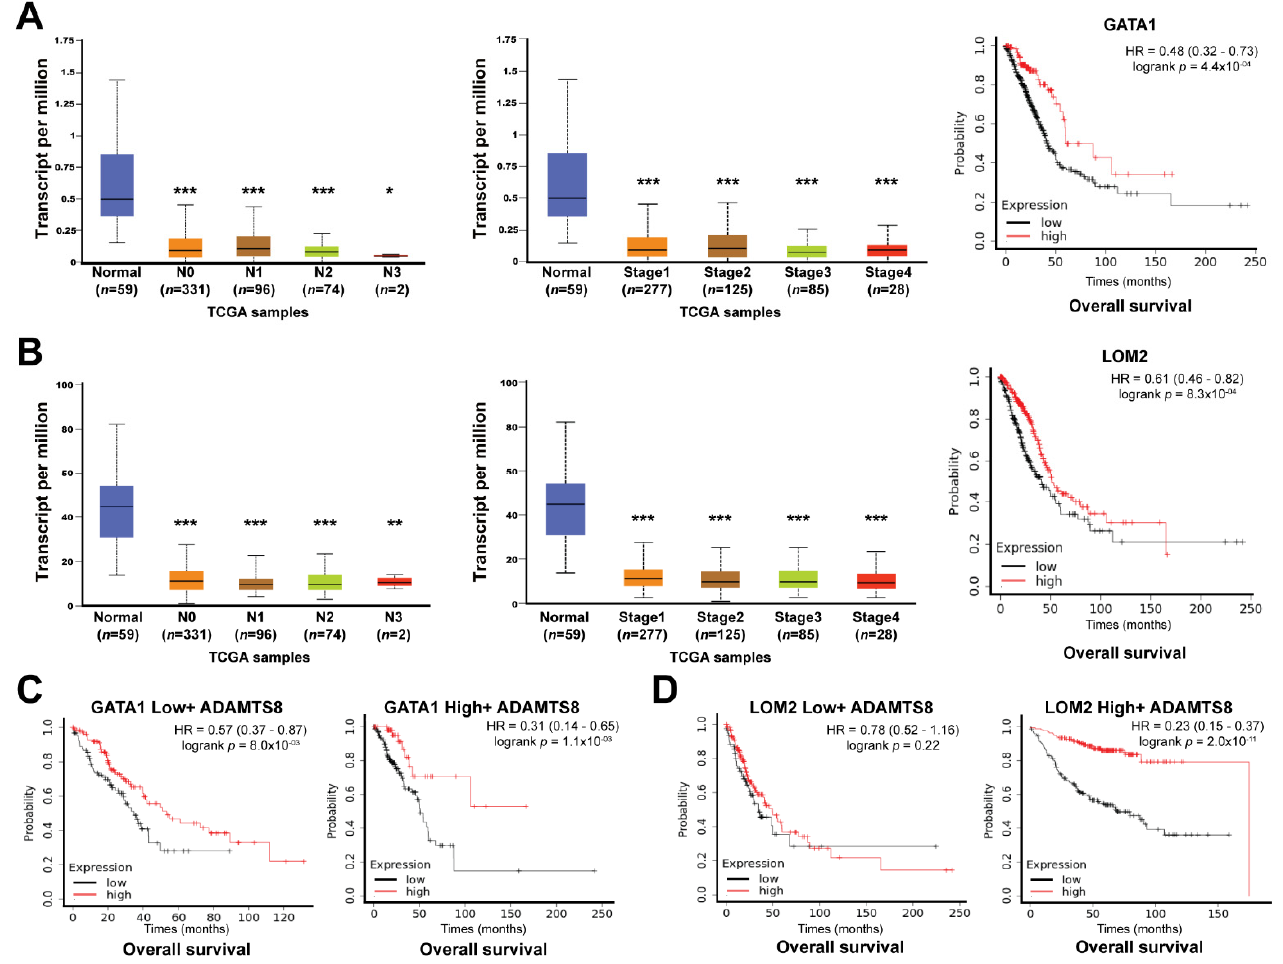
Figure 5. GATA1 regulated ADAMTS8 expression and conferred poor survival. The GATA1 expression in lymph node metastasis and tumor staging (left two panels, A ) and its survival disadvantage (right panel, A ). The LMO2 expression in lymph node metastasis and tumor staging (left two panels, B) and its survival disadvantage (right panel, B ). The cross - analysis of effects of ADAMTS8 on overall survival analysis in lung cancer patients based on either GATA1 ( C ) or LMO2 ( D ). * p < 0.05, ** p < 0.01, *** p < 0.005.